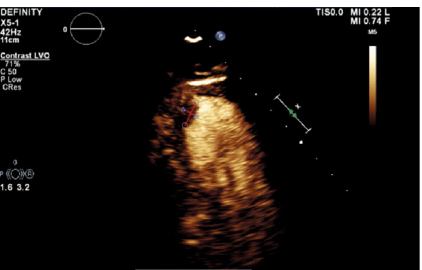
Figure 4: Transthoracic echocardiogram with left ventricular